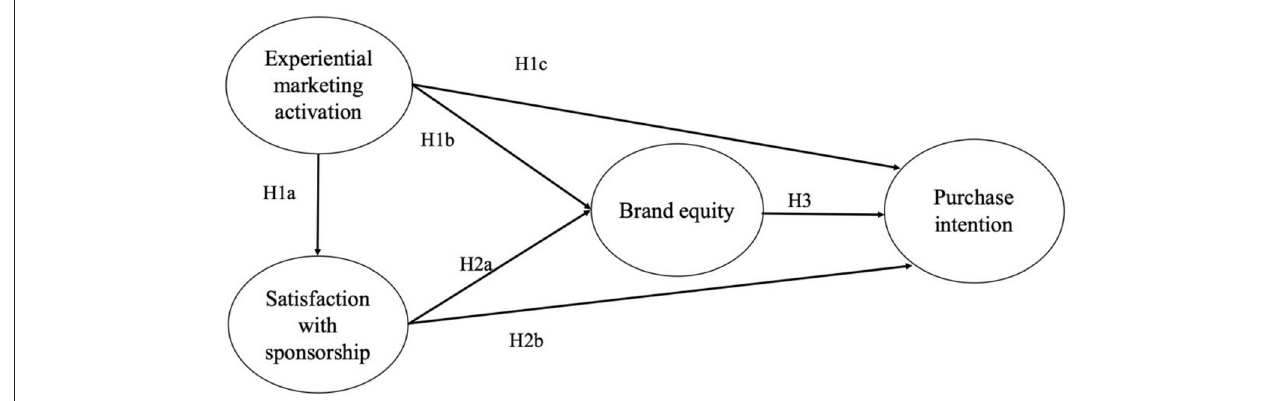
FIGURE 1 | Proposed research